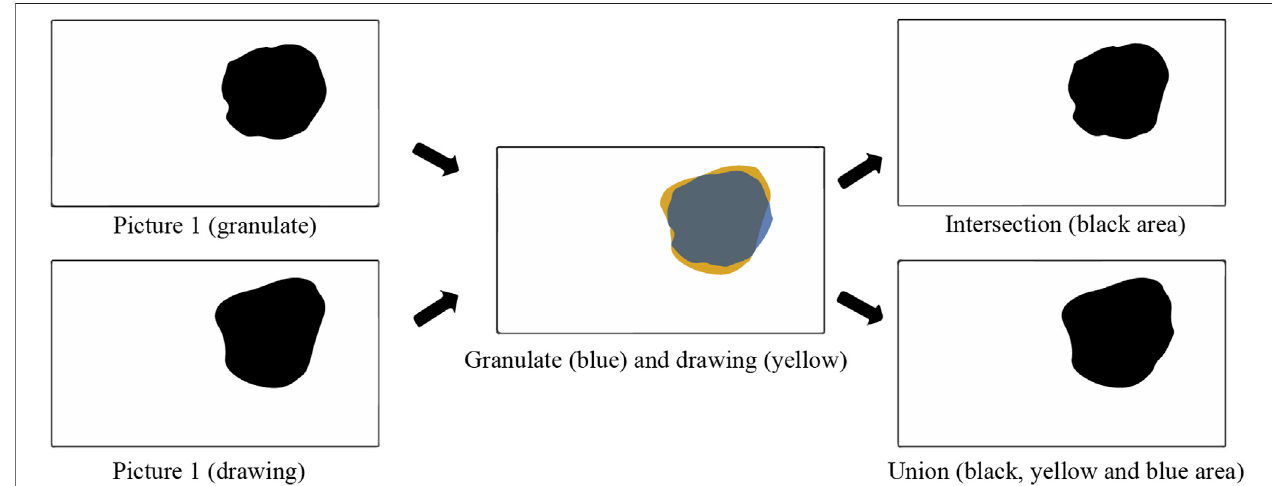
FIGURE 9 | Visual presentation of intersection and